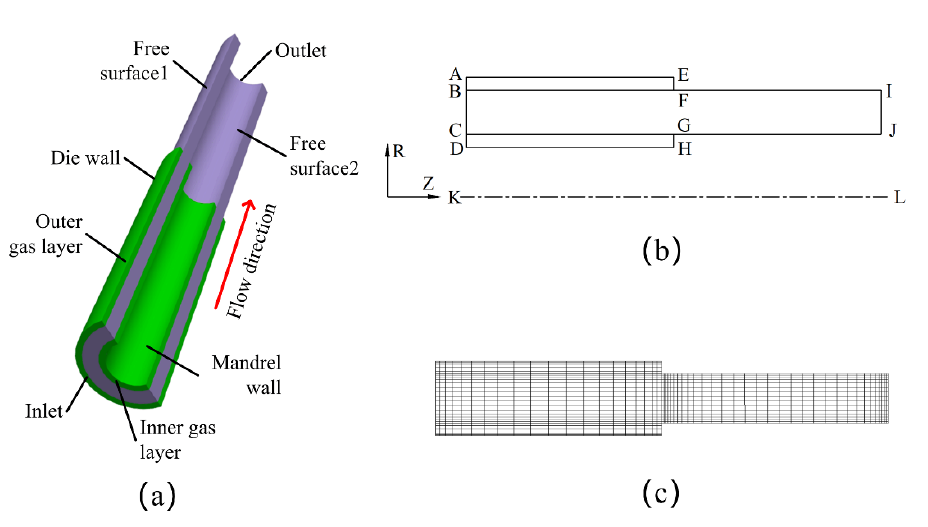
Figure 2. The effect of the grids number on the simulation results. 2.2. Control and Constitutive Equations The following assumptions were made for the finite element simulation process: due to the high viscosity and low velocity of the polymer melt and the very small viscosity and mass of the gas, the inertia forces and gravity effects on these two fluids were ignored. The gas was considered as a compressible Newtonian fluid, while the melt was considered as an incompressible non-Newtonian fluid [39]. The effects of relative slip, interpenetra- tion, and surface tension between the gas and the melt were ignored. The simplified melt and gas control equations are as follows: Continuity Equation: ( ) 0 k k ρν∇⋅ = (1) Momentum conservation equation: